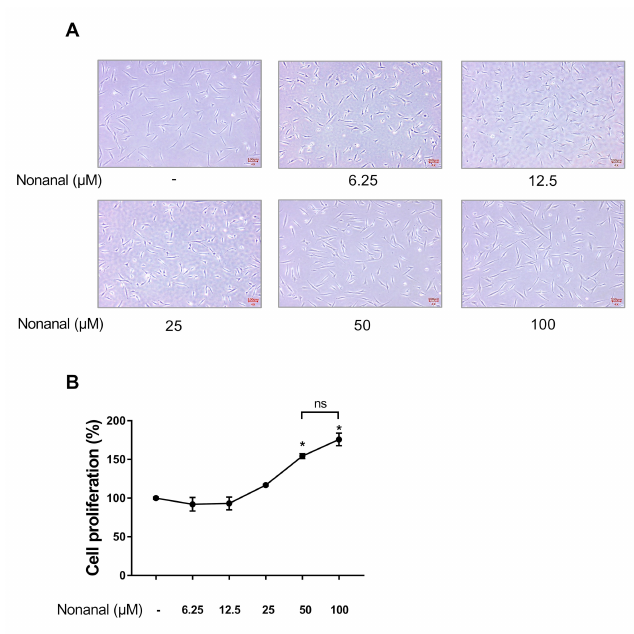
Figure 1. E ff ect of nonanal on dermal papilla cell (DPC) proliferation. DPCs were treated with vehicle (dimethyl sulfoxide; DMSO) or indicated concentrations of nonanal ranging from 6.25 to 100 µ M. ( A ) Representative images of cells in response to nonanal treatment at indicated concentrations for 24 h were captured. ( B ) Cell proliferation was determined in response to nonanal treatment at indicated concentrations for 24 h by WST-1 assay. ( C ) DPCs were exposed to 50 µ M of nonanal at di ff erent time points (12, 24, and 48 h) and cell proliferation was determined by WST-1 assay. Data were statistically analyzed using the Student’s t -test. Data are presented as mean ± standard error of mean (SEM) of the results of three independent experiments. * p < 0.05 vs.